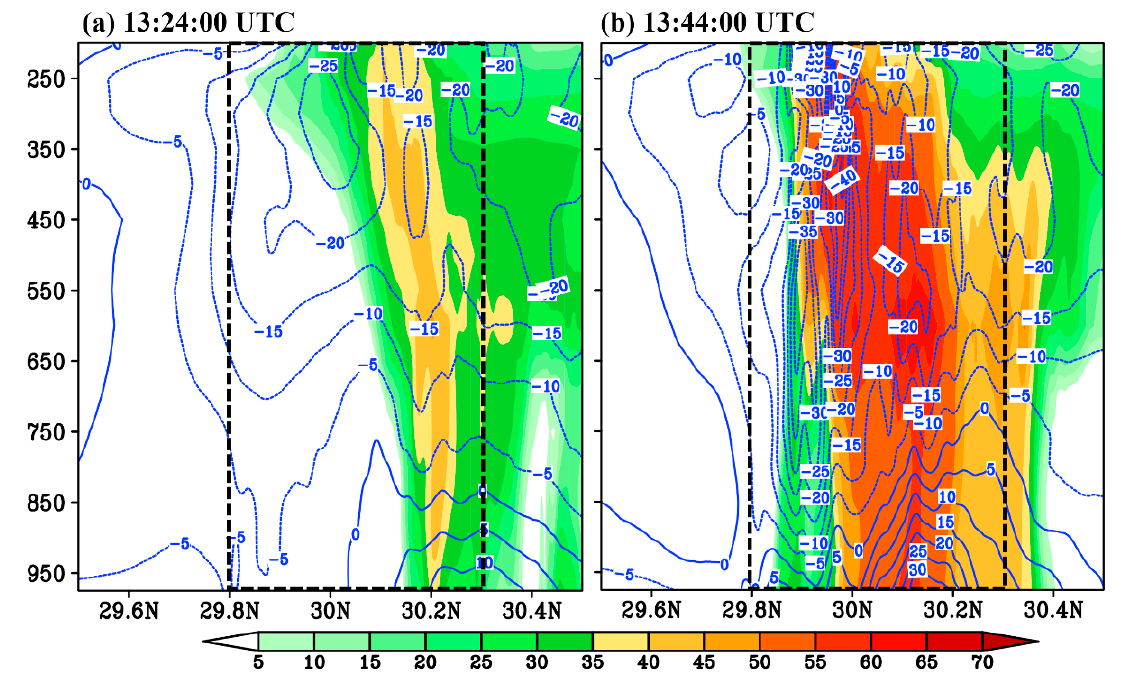
Figure 11. Panels ( a , b ) show the averaged (from 120.24° E to 120.32° E) cross section of the horizontal radar reflectivity (shading; dBZ) and geopotential height deviation (blue contour; gpm) at typical stages, where the black dashed lines mark the key region. The ordinate is pressure and the abscissa is latitude.